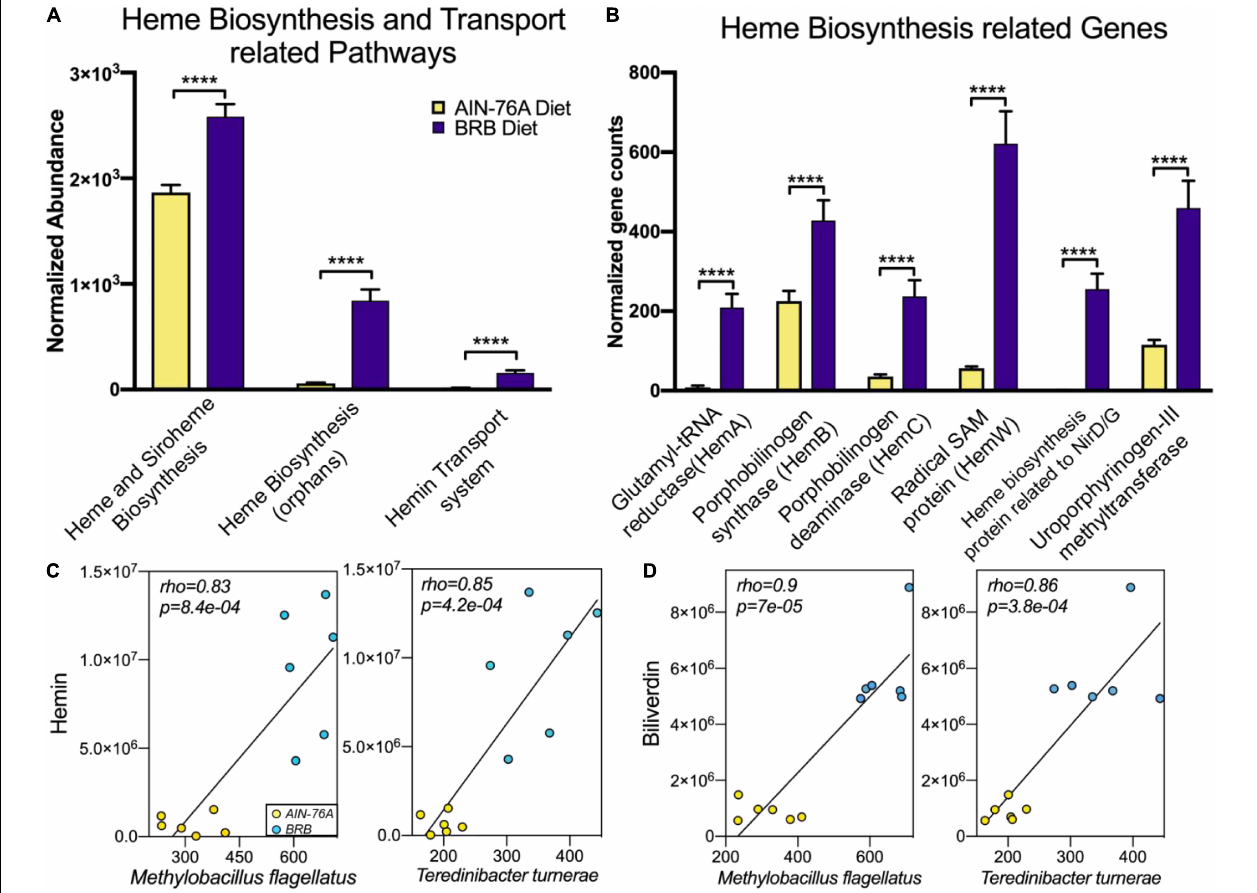
FIGURE 5 | BRB-modulated mouse gut microbiome had enriched bacterial pathways (A) and genes (B) involved in production of heme-related metabolites, which probably contributed to intestinal levels of hemin and biliverdin ( n = 6; DESeq2 FDR adjusted p -value). (C,D) Scatter plots illustrating strong statistical association between relative abundances of gut bacterial species and mass spectrum intensities of hemin (C) and biliverdin (D) , two bacterial species Methylobacillus flagellates and Teredinibacter turnerae are significantly correlated with both hemin and biliverdin ( n = 6; rho > 0.8; p < 0.001), **** p <